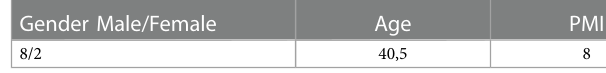
TABLE 2 Gender, mean Age (years) and mean postmortem interval (PMI, days) of the control